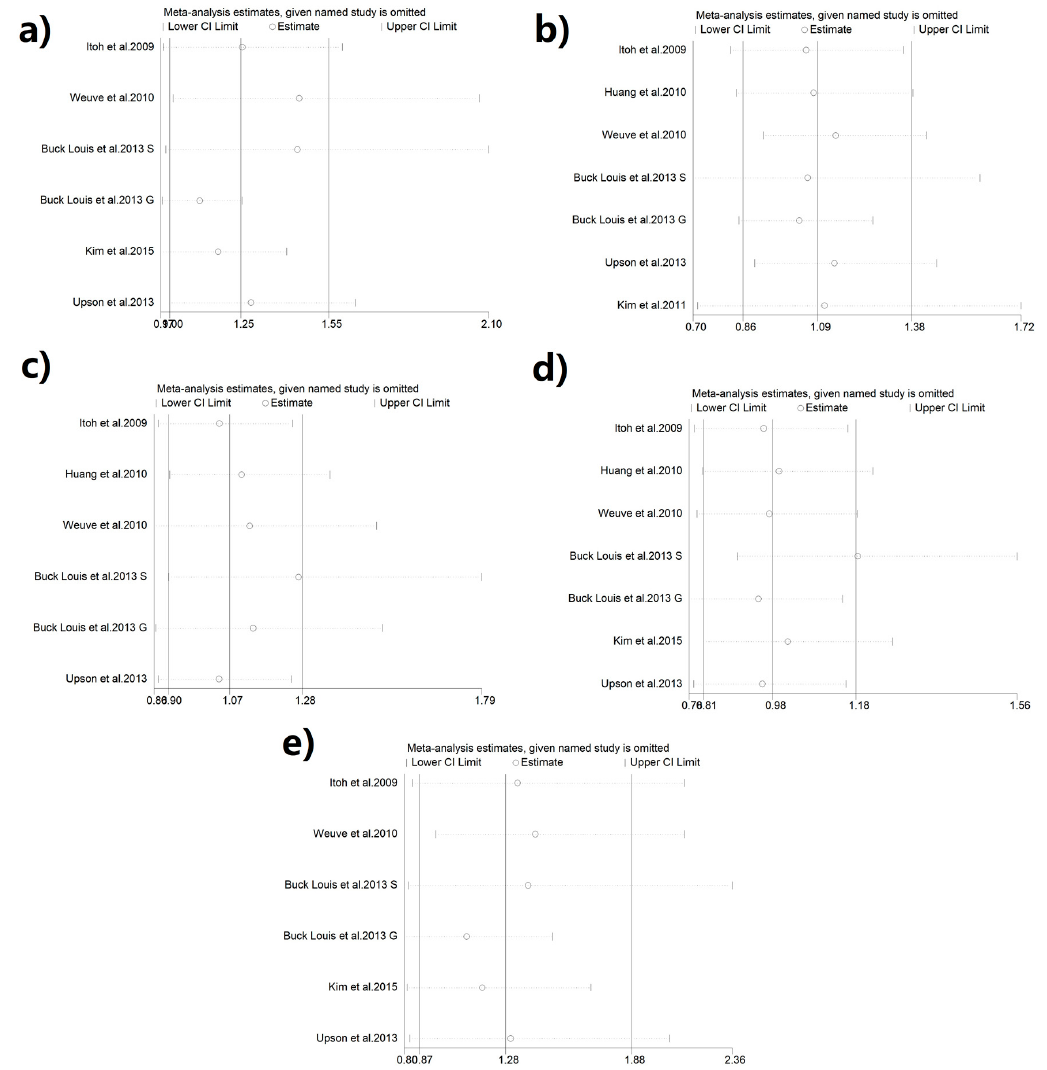
Figure 3. Sensitivity analysis plots: ( a ) MEHHP and endometriosis; ( b ) MEHP and endometriosis; ( c ) MEP and endometriosis; ( d ) MBzP and endometriosis; ( e ) MEOHP and endometriosis.